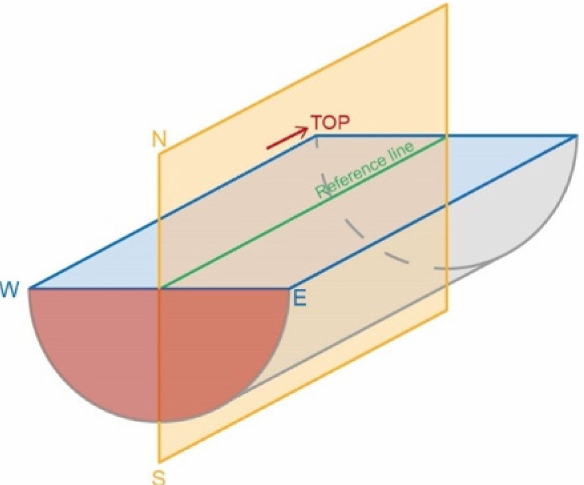
Figure 2. Schematic drawing of the convention used for the measurement of azimuths and dip angles of the different structures present in the cores and techniques used for the measurement of the structural planes in the three dimensions in the interim reference system in the archive half-cores. On the E-W plane (of the interim reference system), the apparent immersions (0–180 ◦ ) of the planes of the various structural elements were measured, where 0 ◦ referred to a horizontal line, perpendicular to the vertical reference line, and 90 ◦ to a vertical line, parallel to the vertical reference line. A second apparent dip angle (90–270 ◦ ) was measured on the half semicircle of the archive half-core, placed on a horizontal plane perpendicular to both the interim E-W and N-S planes, where 90 ◦ referred to a horizontal line, perpendicular to the N-S plane, and 180 ◦ to a vertical line, perpendicular to the E-W plane. The measurement of two different apparent dip angles related to the same plane led to calculate the real orientation of discontinuities (e.g., fractures, joints, and stylolites) planes (and related poles), referred to the reference system described above, through Stereonet software [105]. Then, calculated data from Stereonet were reported on Dips software [106] to generate a rose diagram to represent the dip directions of the various structures, while histograms were used to indicate the frequency of the various dip angles and the number of fractures per linear meter. Other data frequency of the length of the fractures, opening, etc.) were reported in histograms (see Section